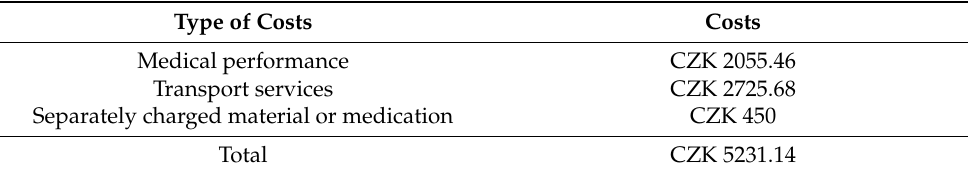
Table 5. The overall transport